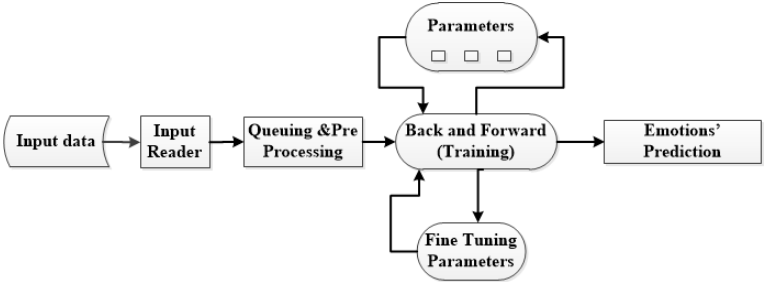
Figure 2. TensorFlow dataflow graph for training tweets data.